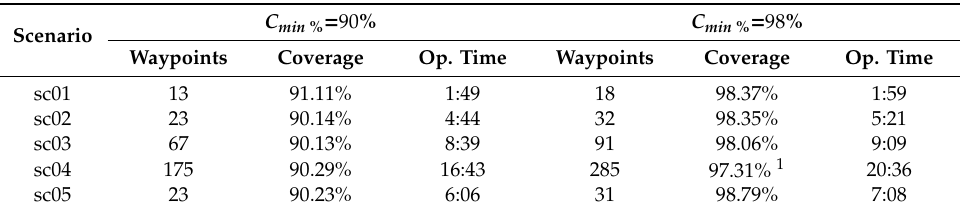
Table 4. Optimization of the number of waypoints.